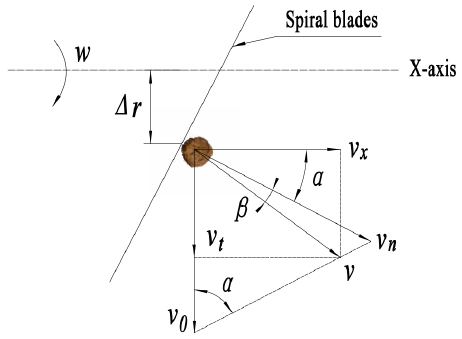
Figure 3. Tiger nut velocity analysis.